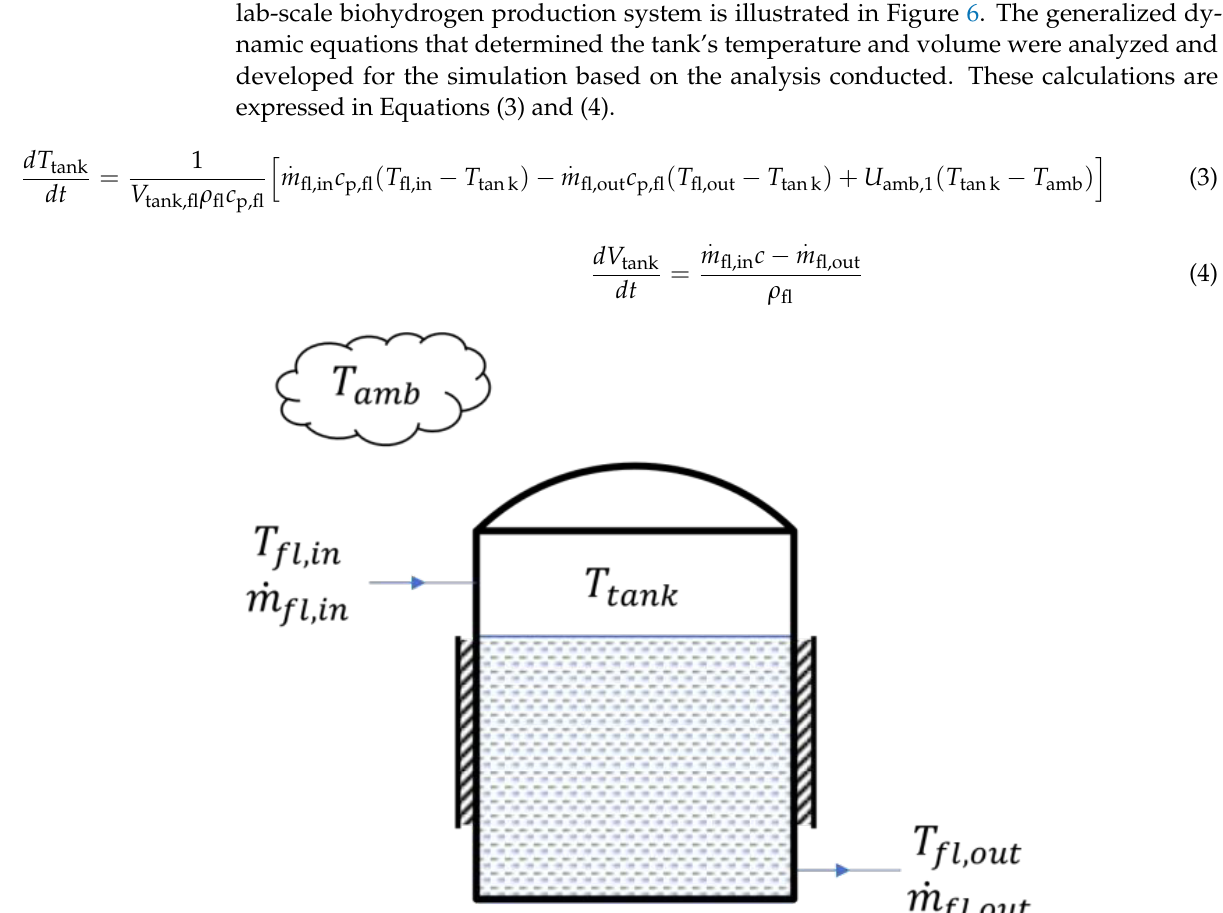
Figure 5. Steam boiler temperature profile.